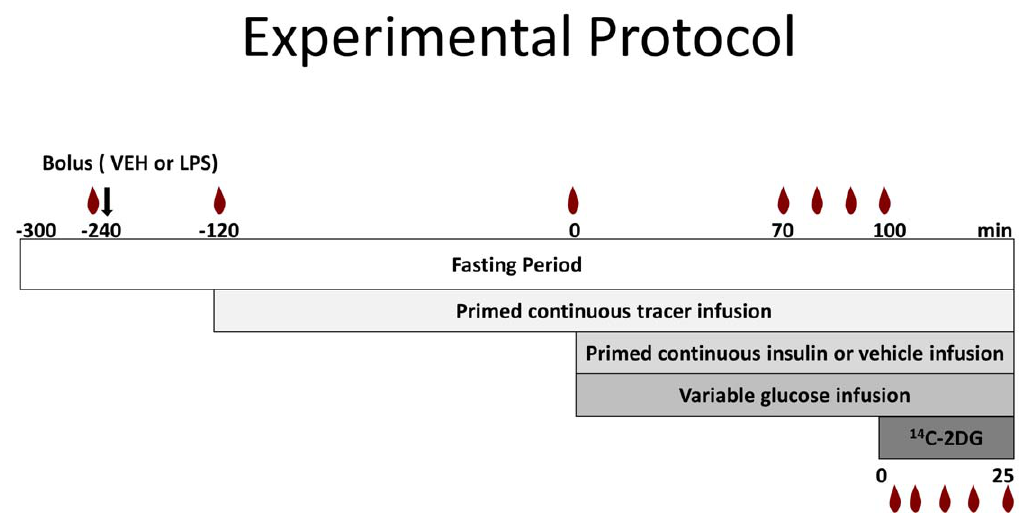
Figure 1. Protocol used during the hyperinsulinemic-euglycemic clamp. On the day of the in vivo metabolic experiments, chronically catheterized conscious mice were placed on a 5 h fast (t= 2 300 min). A bolus of VEH, low- or high-dose LPS was injected at t= 2 240 min. At t= 2 120 a primed continuous tracer infusion was begun. At t=0 an infusion of insulin and glucose or vehicle (i.e. saline) was initiated. After 100 min, 2-deoxy glucose was injected and mice were sacrificed after 25 min.